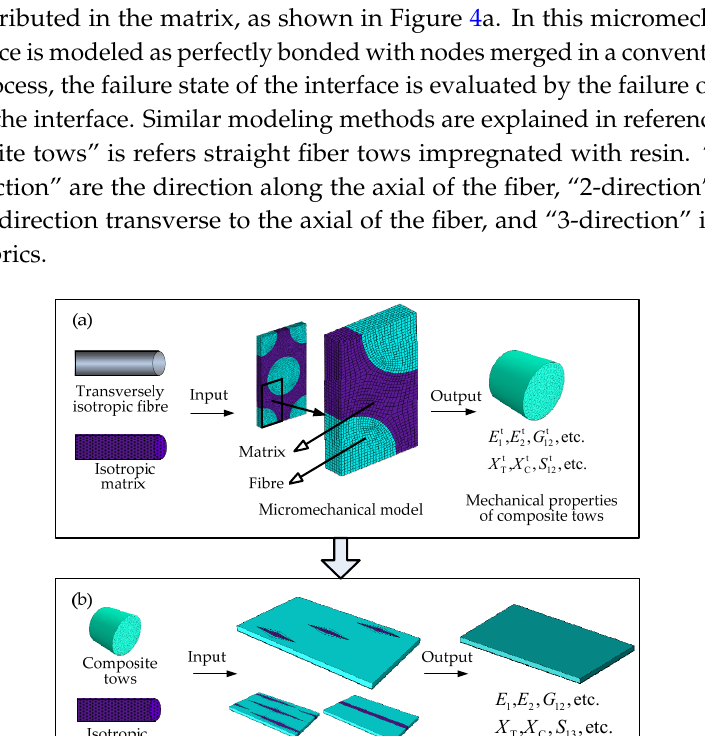
Figure 4. The workflow of multiscale analysis: ( a ) microscale; and ( b ) mesoscale.